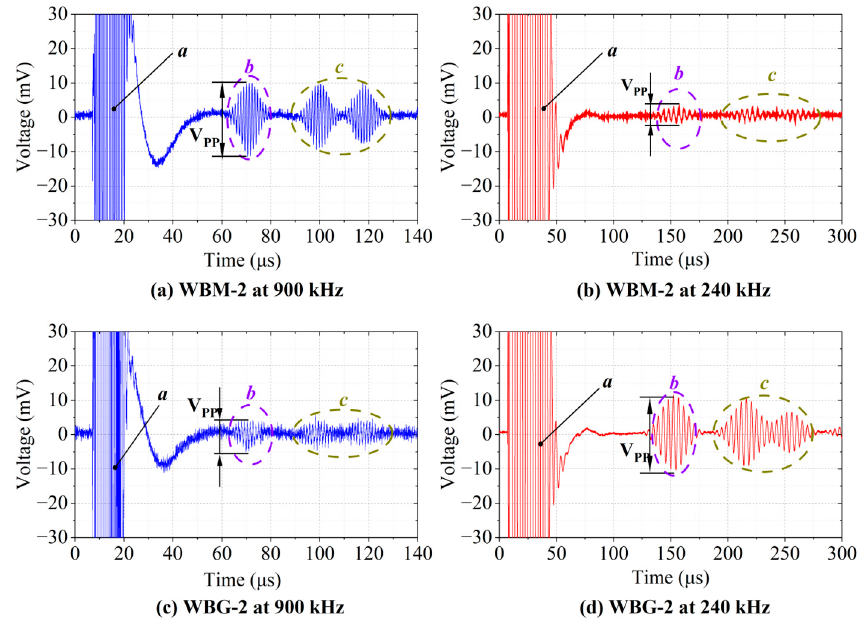
Figure 17. Signals received by the WBM-2 and WBG-2 EMATs. ( a ) Signal of WBM − 2 EAMT at 900 kHz. ( b ) Signal of WBM-2 EMAT at 240 kHz. ( c ) Signal of WBG-2 EMAT at 900 kHz. ( d ) Signal of WBG-2 EMAT at 240 kHz. Packets a are the crosstalk signals, packets b are the direct waves, and packets c are echoes reflected by the left and right edges of the aluminium plate. V PP is the peak-to-peak value of packets b .